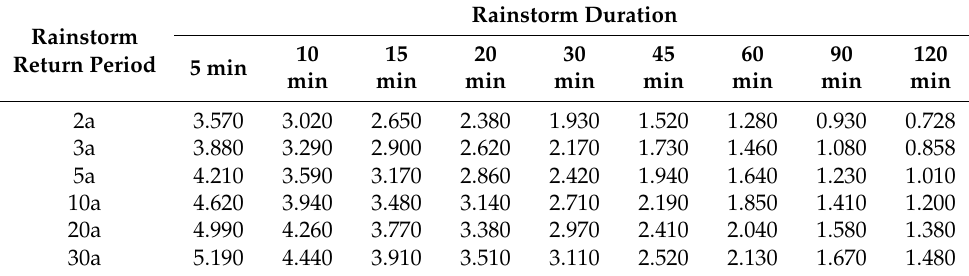
Table 6. Same as Table 4 but for RCP8.5 scenario (units: mm/min). Rainstorm